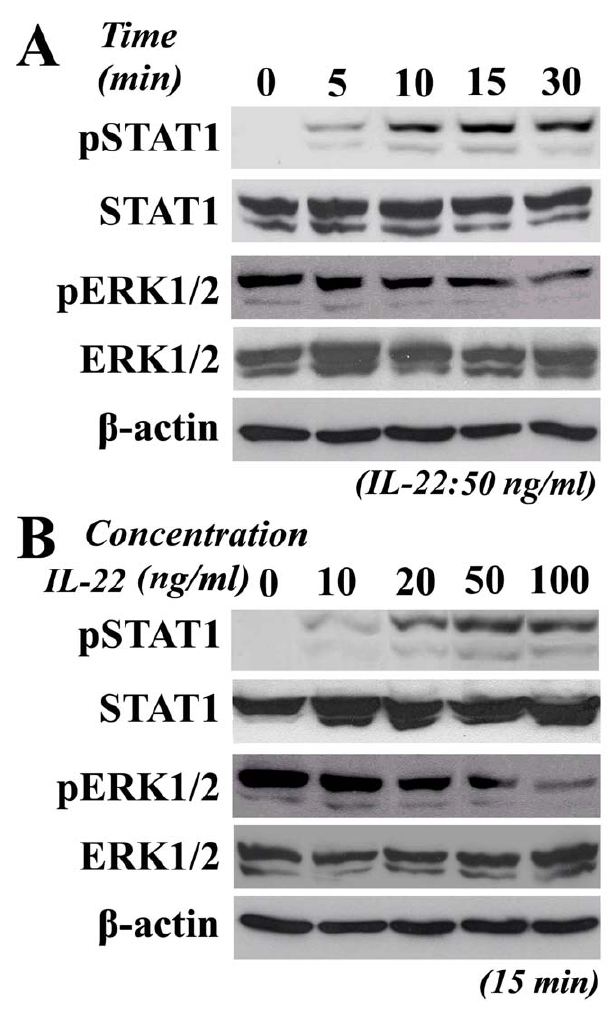
Figure 5. The regulation of STAT1 and ERK1/2 pathways by rhIL-22. A. p-STAT1 and p-ERK1/2 levels after 50 ng/ml rIL-22 exposure. B. p-STAT1 and p-ERK1/2 levels 15 minutes after administration of various doses of rhIL-22. N=3.